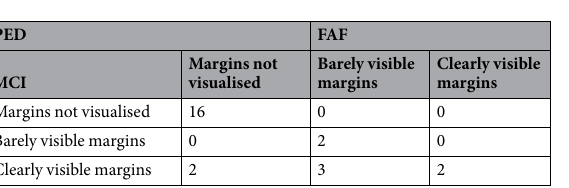
Table 4. Comparison of definition (distinctness) of pigment epithelium detachment (PED) on multicolour imaging (MCI) and fundus autofluorescence (FAF). In 20/25 (80%) eyes, the grading was consistent while in five eyes there was a discrepancy with all five eyes favouring